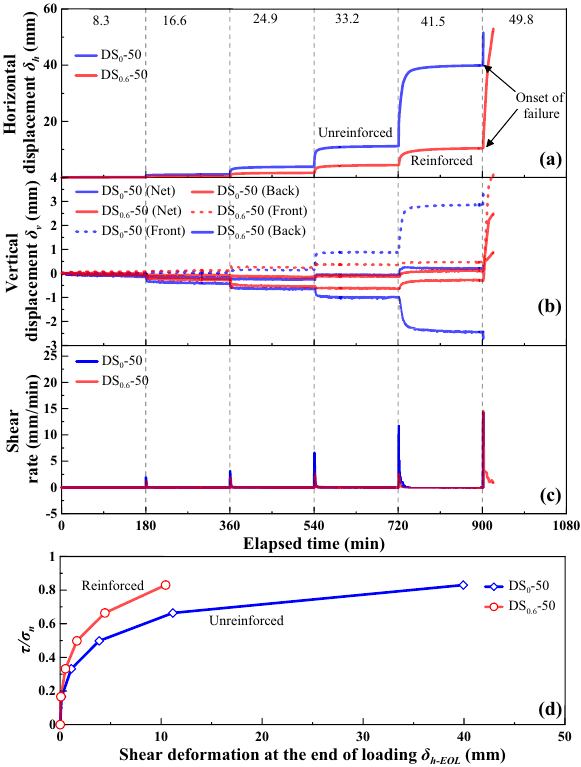
Figure 5. Shear behaviour for the reinforced specimen ( ω = 18% and %waste straw = 0.6) and the unreinforced specimen ( ω = 18%) under σ n = 50 kPa: ( a ) shear displacement ( δ h ) versus elapsed time relationship, ( b ) vertical displacement ( δ v ) versus elapsed time relationship ( c ) shear rate versus elapsed time relationship, and ( d ) ratio of shear stress to total normal stress ( τ / σ n ) versus shear displacement at the end of each increment of shear load ( δ h-EOL )